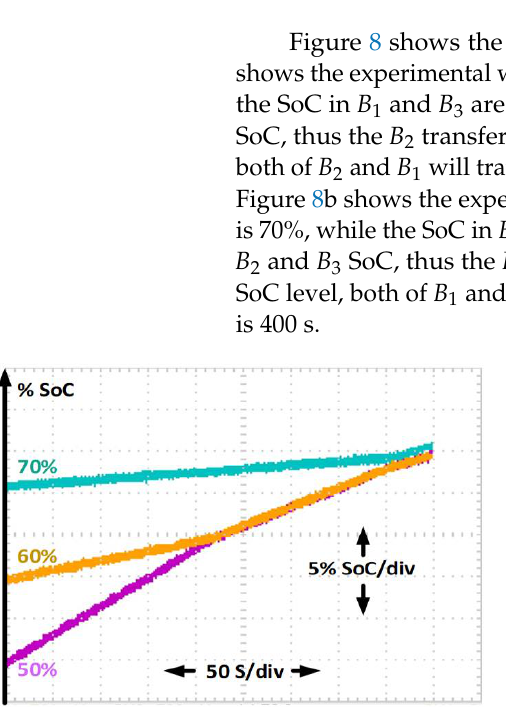
Figure 7. Series LC resonant into BMS ( a ) for preheating mechanism testbed; ( b ) for LC resonant tank testbed.